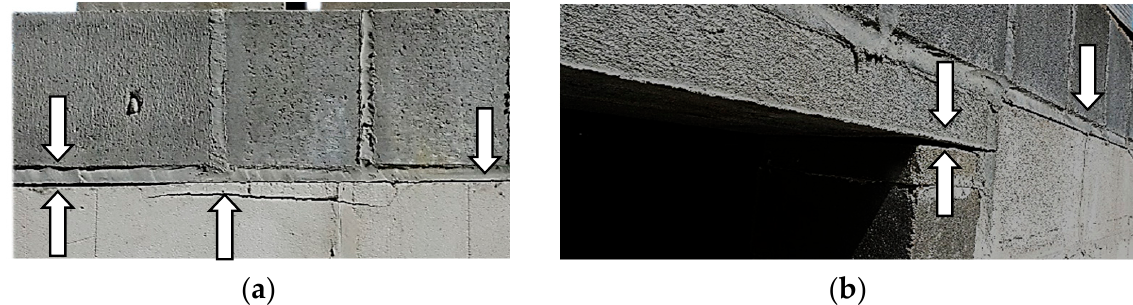
Figure 14. Cracks on the LGR model exposed to long-term loading: ( a ) in the interface between the bond beam and the masonry unit (corner B) and ( b ) between the lintel and the masonry unit.